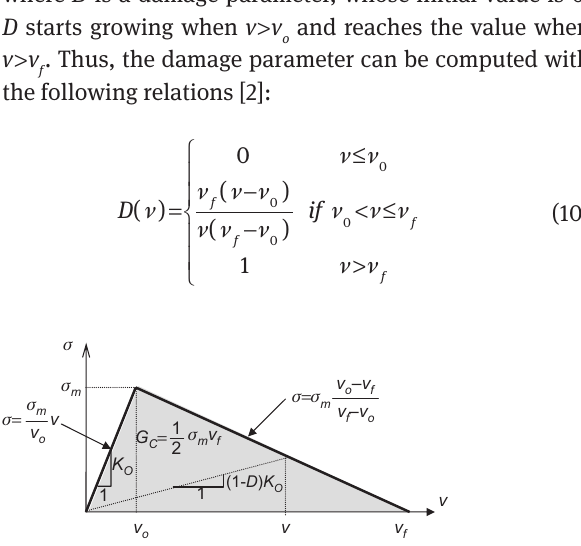
Figure 1 Body Ω involving discontinuity caused by two cohesive segments. Figure 2 Bilinear interface traction for Mode I